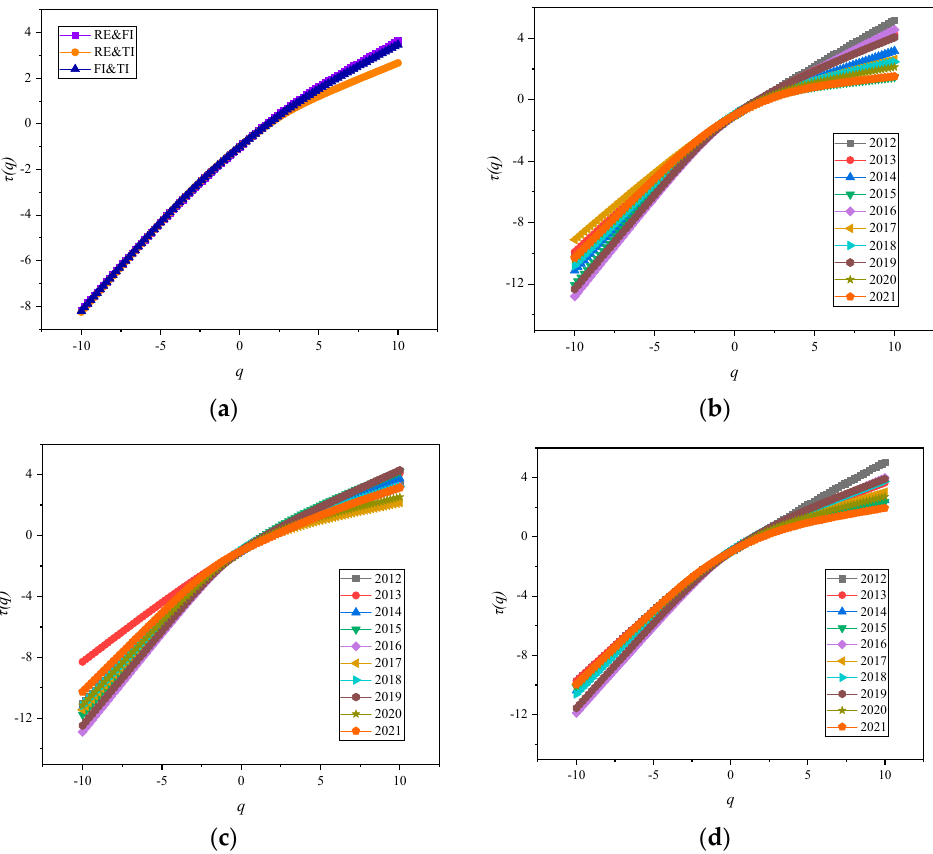
Figure 6. The 𝑞 - 𝜏(𝑞) results of the TI, FI, and RE. ( a ) Overall sample. ( b ) Subsample RE and FI. ( c ) Subsample RE and TI. ( d ) Subsample FI and TI.